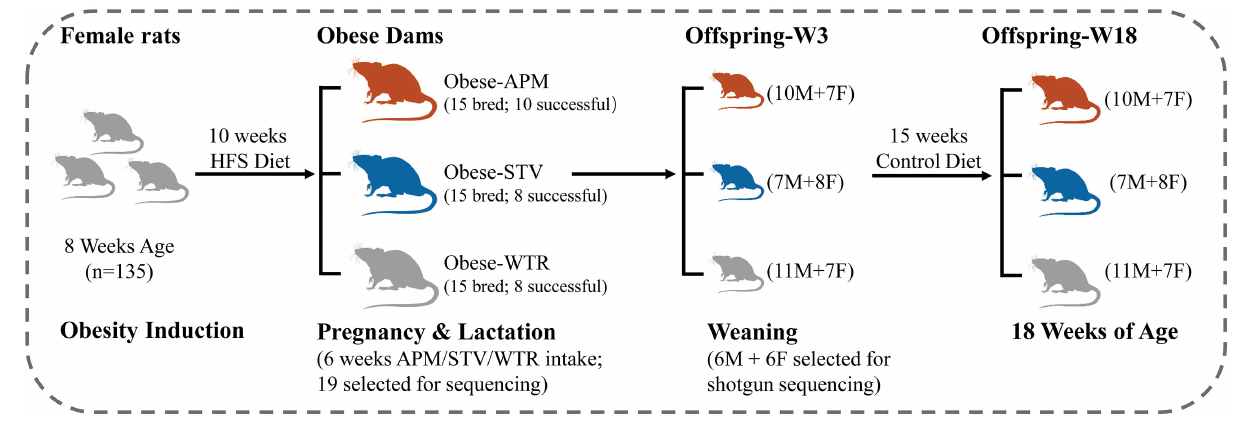
FIGURE 1 | Study design. HFS, high fat/sucrose diet; APM, aspartame; STV, stevia; WTR, water control; M, male; F, female; W,